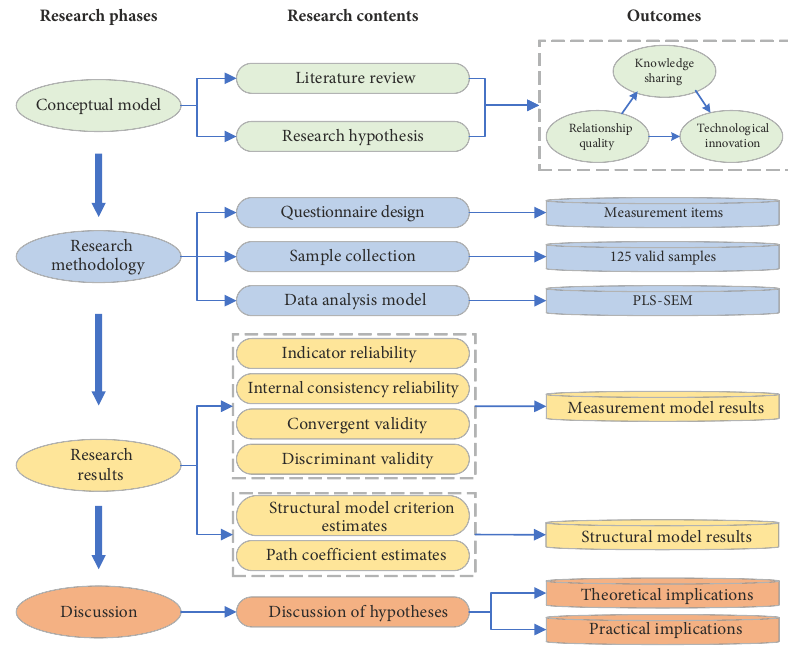
Figure 2. Research